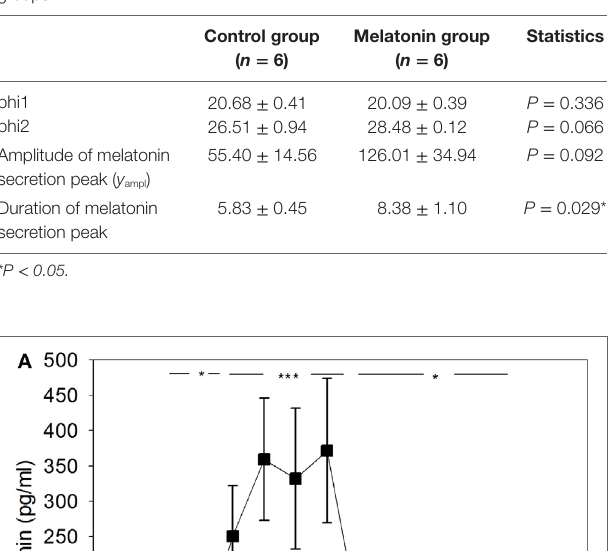
TaBle 1 | Mean values ± SEM of individual phi1 and phi2, amplitude, and duration of the melatonin secretion peak in melatonin-implanted and control groups.